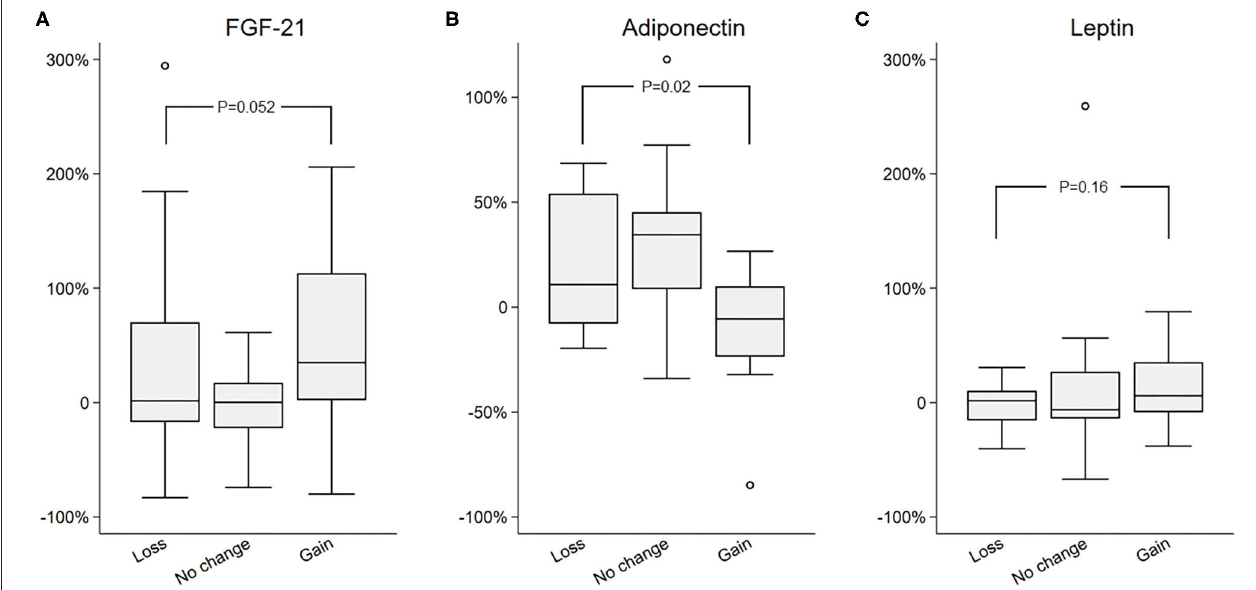
FIGURE 1 | Comparison of percent change in (A) FGF21, (B) Adiponectin, and (C) Leptin in the loss, no change, and gain groups.